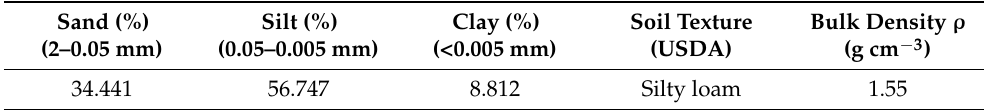
Table 1. Particle size distribution and texture of soil used in the study.